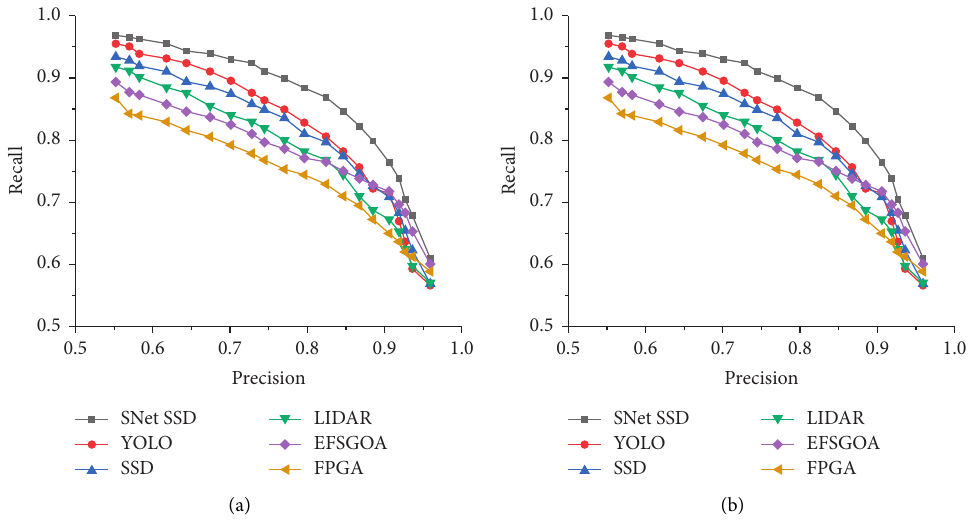
Figure 9: Performance analysis of different models under different